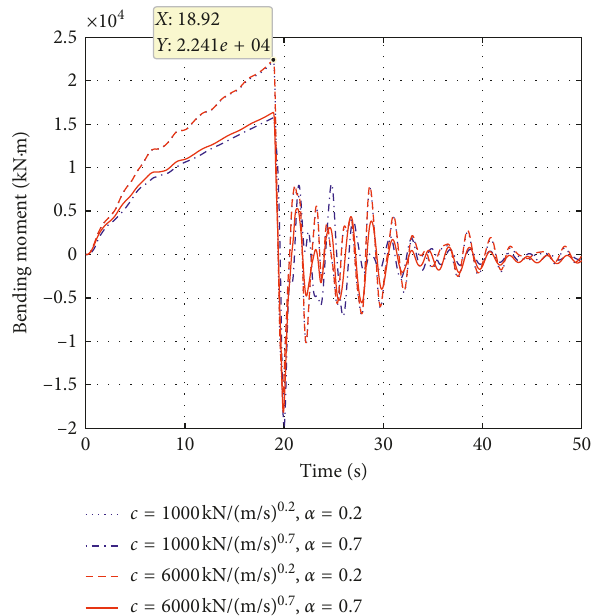
Figure 19: Longitudinal bending moment at the bottom section of the main